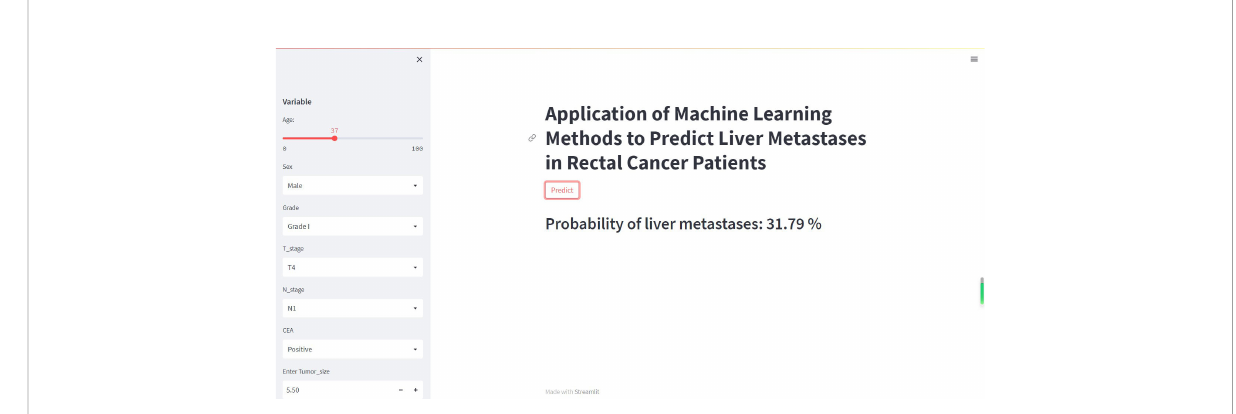
FIGURE 7 The machine learning model-based web predictor for predicting liver metastasis in rectal cancer